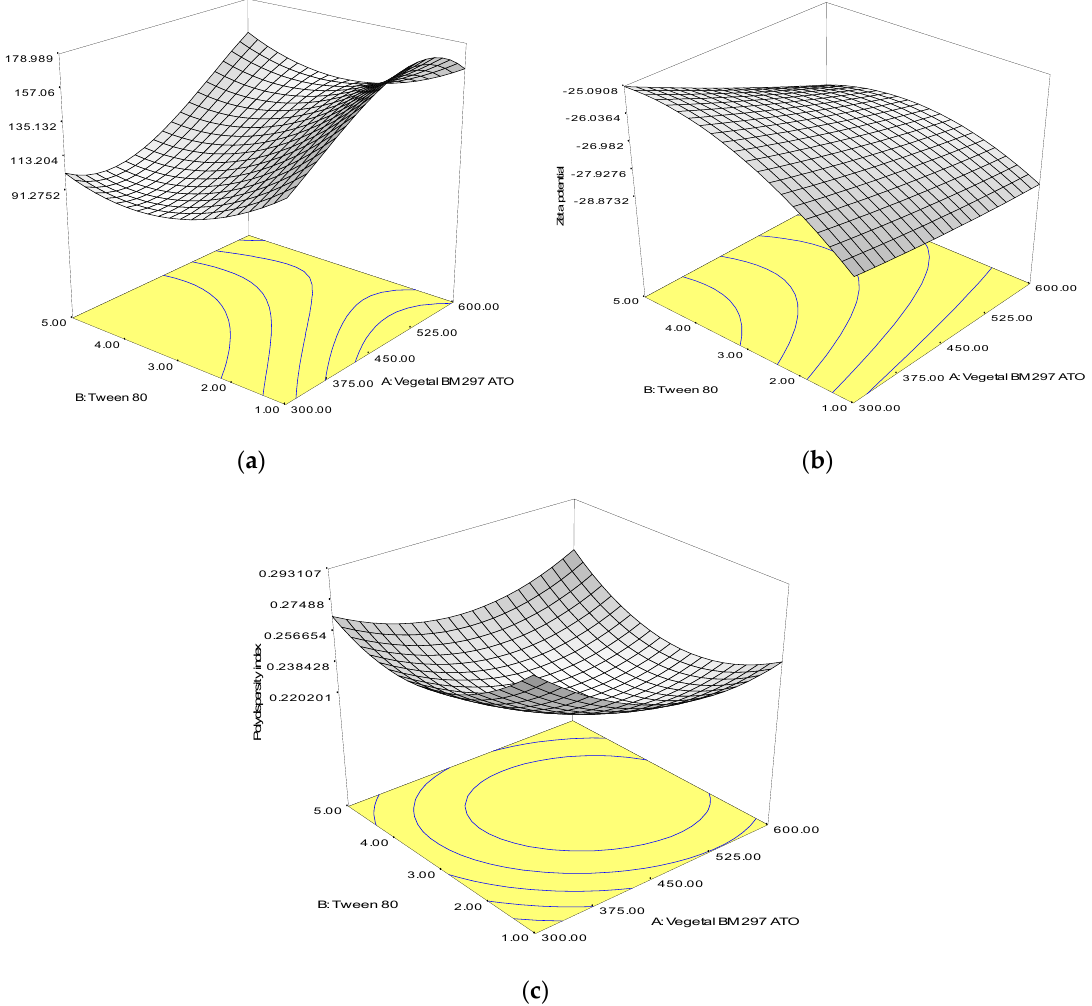
Figure 1. Response surface plots showing the effect of interaction between Biogapress Vegetal 297 ATO and Tween 80 compositions on: ( a ) particle size; ( b ) zeta potential; and ( c ) polydispersity index.